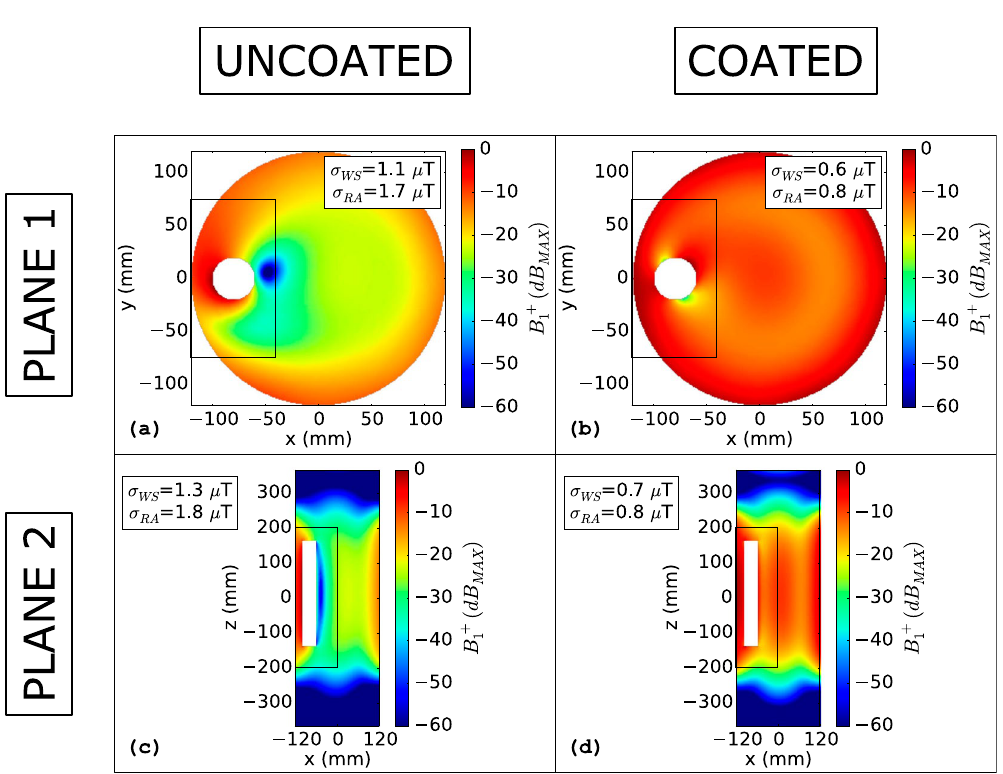
Figure 4. B 1 + ( dB MAX ): Lateral metallic cylinder. B 1 + ( dB MAX ) evaluated for the cylinder plunged into the phantom in a lateral position ( − 80 mm from the phantom centre to the cylinder centre). Figures ( a ) and ( b ) depict the uncoated and coated object situations, respectively, for the transverse plane that cuts the cylinder in two equal parts along the longitudinal direction. Figures ( c ) and ( d ) depict the uncoated and coated object conditions, respectively, for the longitudinal plane that cuts the phantom in two equal parts. The rectangular areas represent the reduced areas in which the standard deviation ( σ RA ) was computed. σ WS represents the standard deviation computed on the whole